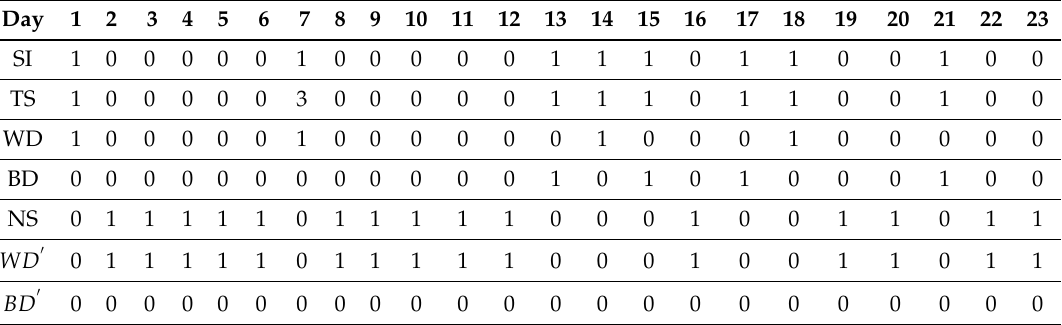
Figure 10. The results of group 2 in ASPF. ( a ) denotes that there is a similar day, and the MxAE between the actual solar power and historical value is less than ∆ 2 ; on the contrary, ( b ) shows that the MxAE is larger than ∆ 2 ; ( c ) plots a curve that the ∆ 1 in group 2 changes with the similar days’ message; ( d ) shows the ∆ 2 in group 2 changing with MxAE. Table 7. The results of ASPF in group